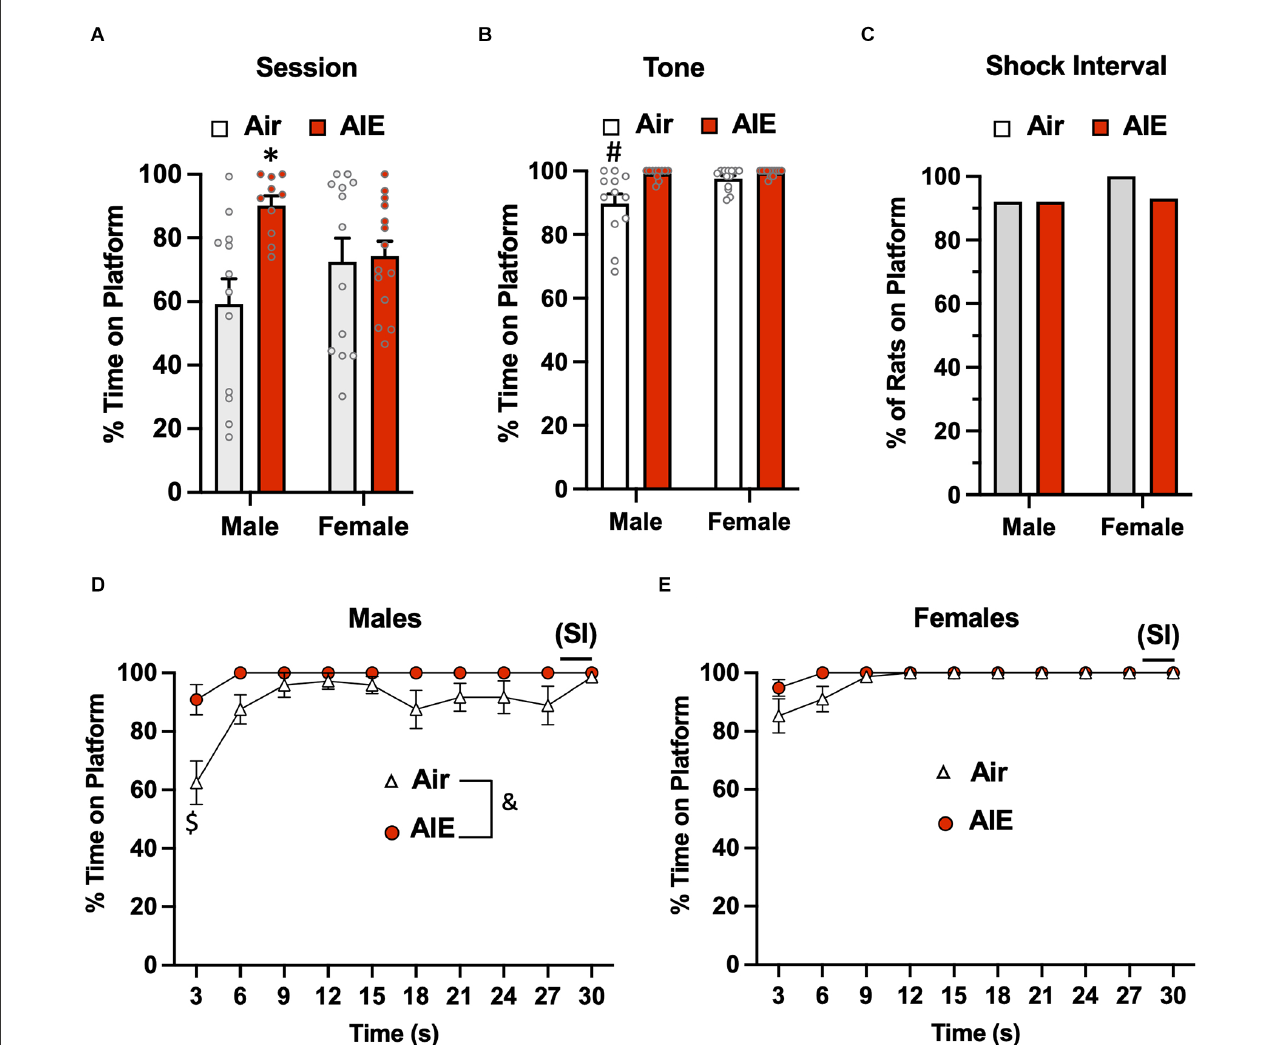
FIGURE2 Active avoidance behavior assessed on the test day of the platform-mediated avoidance task. (A) When examined over the entire test session, AIE-exposed male rats spent significantly more time on the platform compared to the male Air control animals. (B) When the analysis of time on the platform was restricted to the periods of the 30-s tone, both male and female rats were located on the platform to a much greater extent compared to the tone-off periods. In addition, the significant difference in time on the platform between the male Air and male AIE-exposed rats was still observed. (C) Chi-square analysis revealed there was no significant difference in the percentage of rats that remained located on the platform during the 2-s shock interval (SI) at the end of the tone. Analysis of the time-course in 3 s bins of when the male (D) and female (E) rats were positioned on the platform during the tone revealed a significant main effect of AIE in the male rats. This was primarily driven by the significant difference observed at the initial 3 s time point. Data represent the means ± sem (except for the contingency date in panel C ; n = 12–13/group). ∗ indicates significant difference from male Air rats, p = 0.013; # indicates significant difference from all other groups, all p values < 0.01; $ indicates significant difference of Air and AIE at the 3 s time point, p = 0.000; & indicates significant main effect of AIE, p = 0.009.